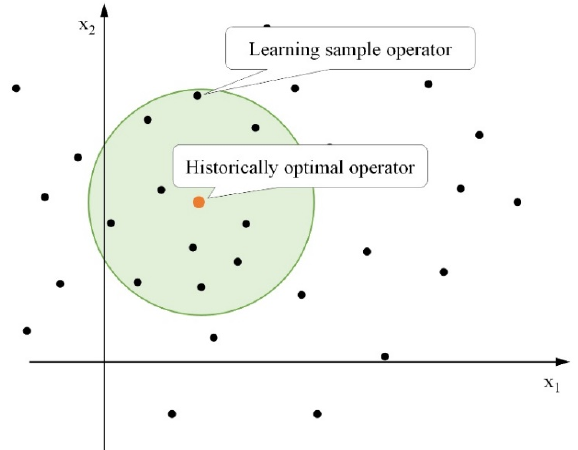
Figure 2. Schematic of the empirical dataset for the surrogate model.